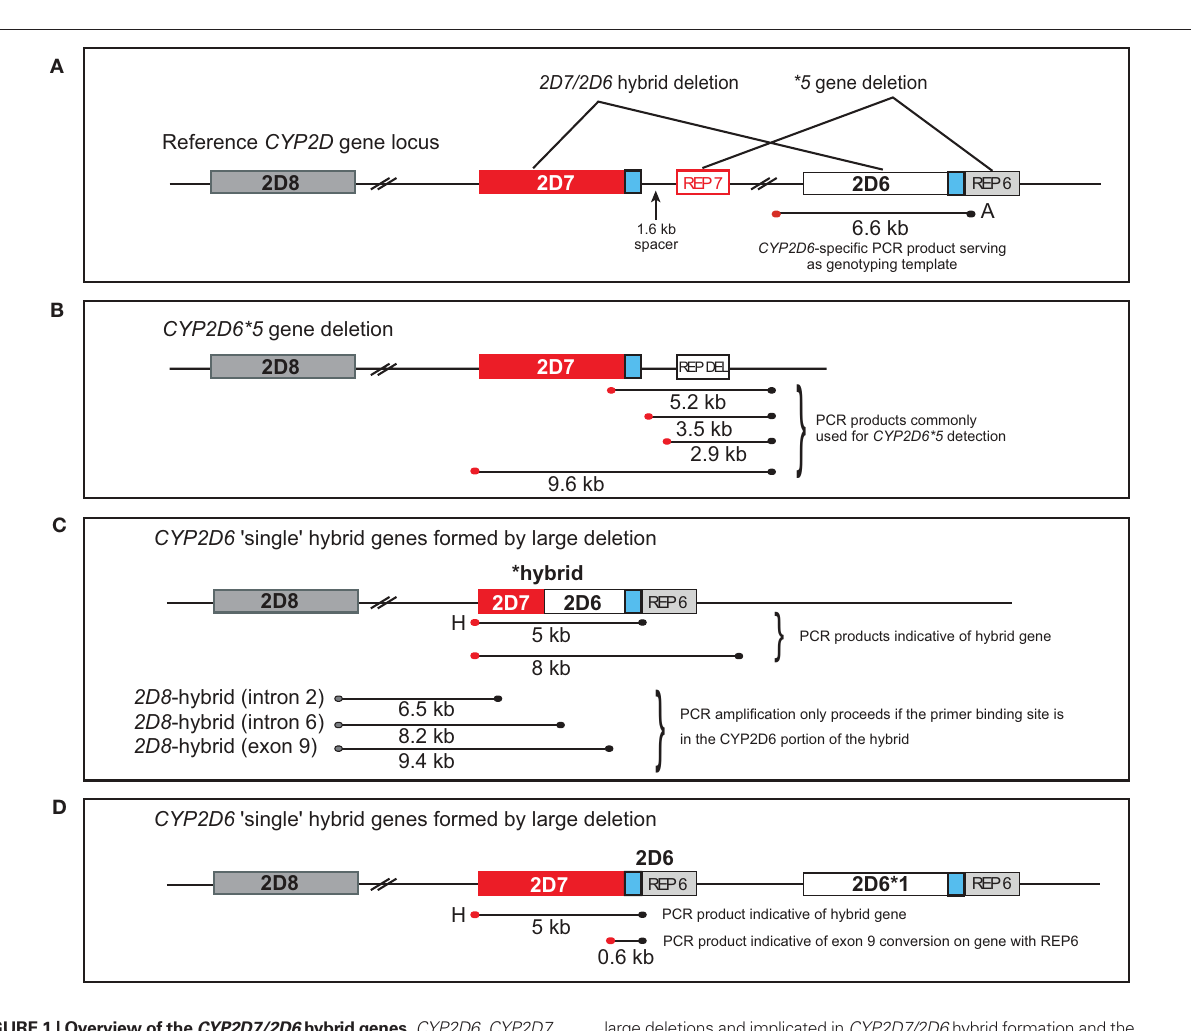
Figure 1 | Overview of the CYP2D7/2D6 hybrid genes. CYP2D6, CYP2D7, and CYP2D8 genes are shown in light gray, red, and dark gray boxes, respectively. The 600-bp repeat element immediately downstream of exon 9 is shown in blue. CYP2D6 and CYP2D7 -derived repetitive elements (REP) are in red and light gray; REP-DEL indicates a fused repeat element generated by a large deletion involving parts of those elements from both genes. PCR fragments generated are represented as lines and their sizes are given in kilobyte. Red and black endpoints denote primer specificity to CYP2D6 and CYP2D7 . (A) Graph represents the CYP2D reference locus. Areas affected by